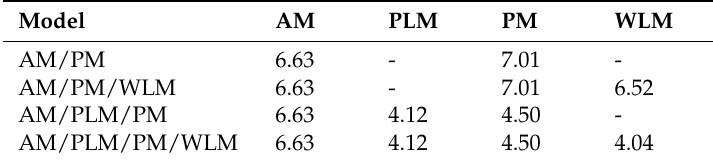
Table 4. Results of different group in ASR